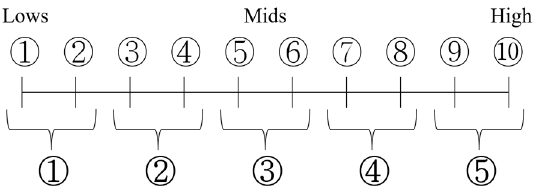
Figure 2. Construction of individual’s subjective socioeconomic status level.